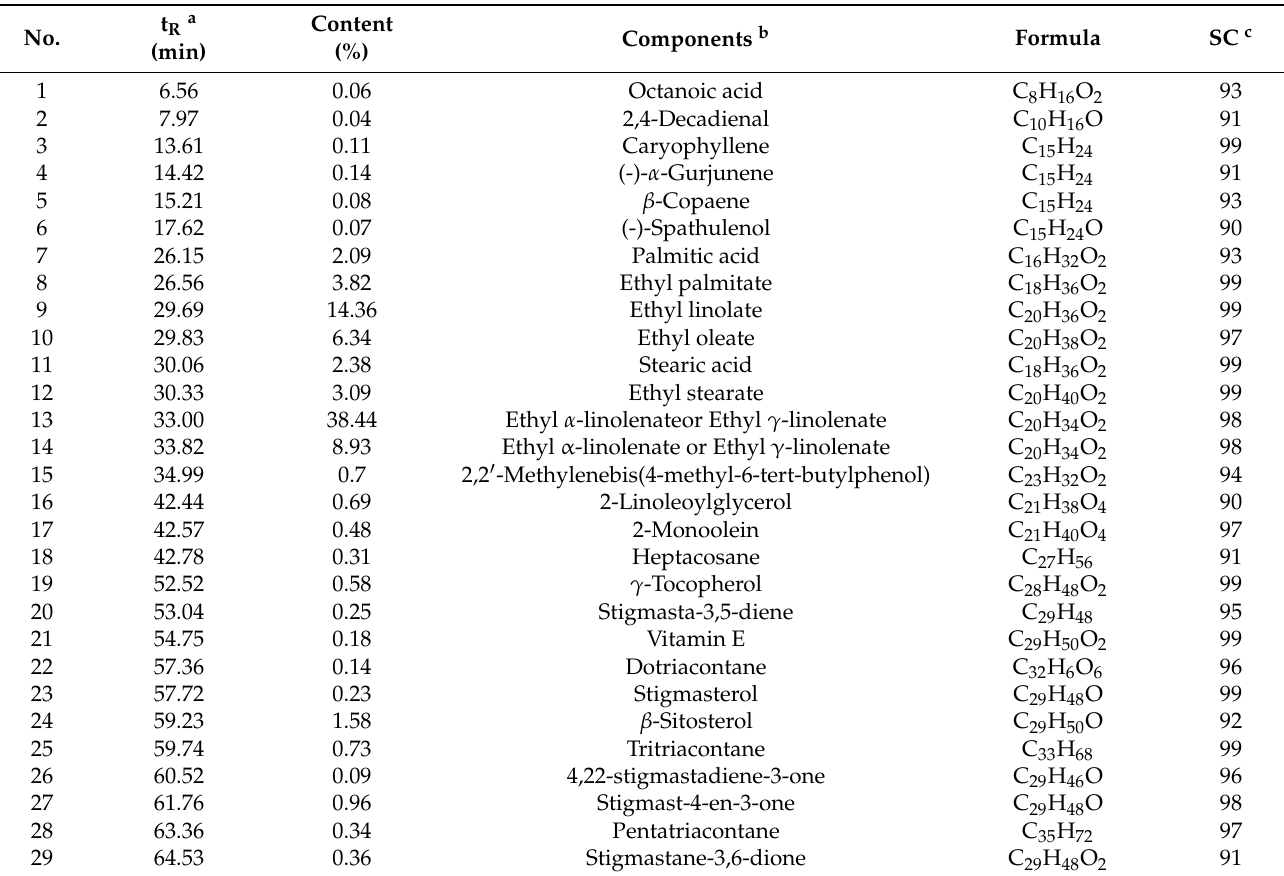
Table 3. Compounds estimated from PE extracts of tung meal by GC-MS.